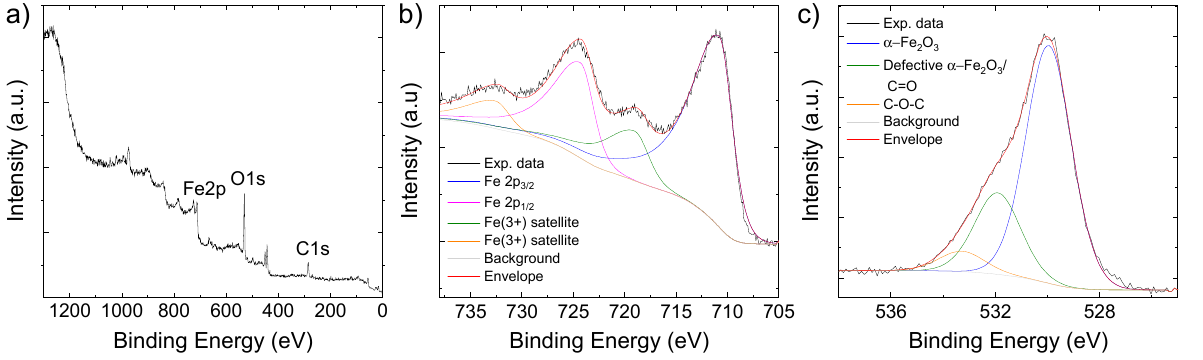
Figure 3. ( a ) Wide scan; ( b ) Fe 2p; ( c ) O 1s XPS spectra, of C-Fe 2 O 3 .